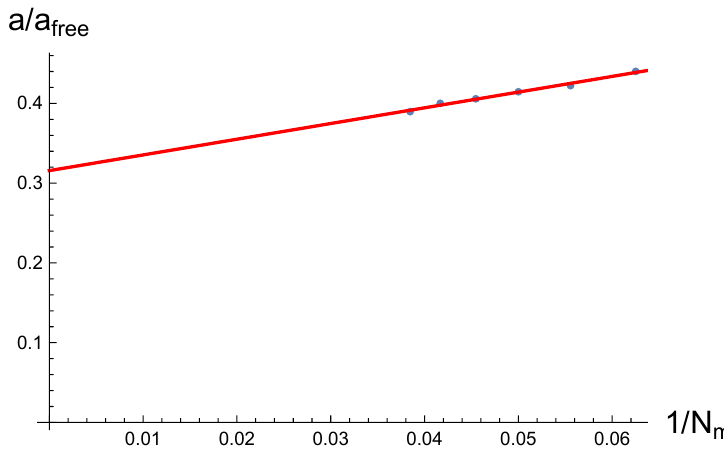
Figure 5 . Minimum possible value of the a-anomaly without any further assumptions as a function of 1 /N max with L max = N max + 10 . The numerical results are depicted by blue points. Linear extrapolation to N max → ∞ depicted by the red line gives 0 . 316 ± 0 . 015 for the minimum of a/a free